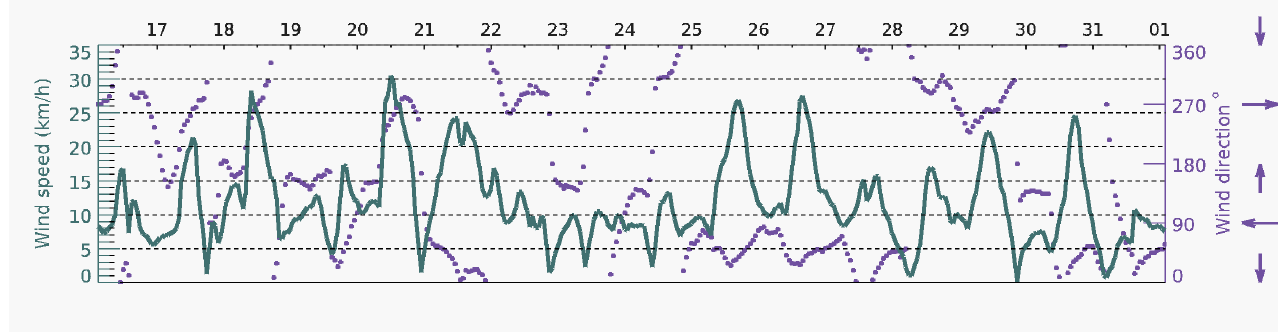
Figure 8. Wind speed and direction information for Izmit Bay between 17 May 2021 and 31 May 2021 (source: www.meteoblue.com, accessed on 15 June 2022).